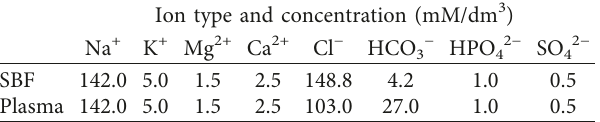
Table 1: Ionic composition of the SBF solution. Ion type and concentration (mM/dm 3